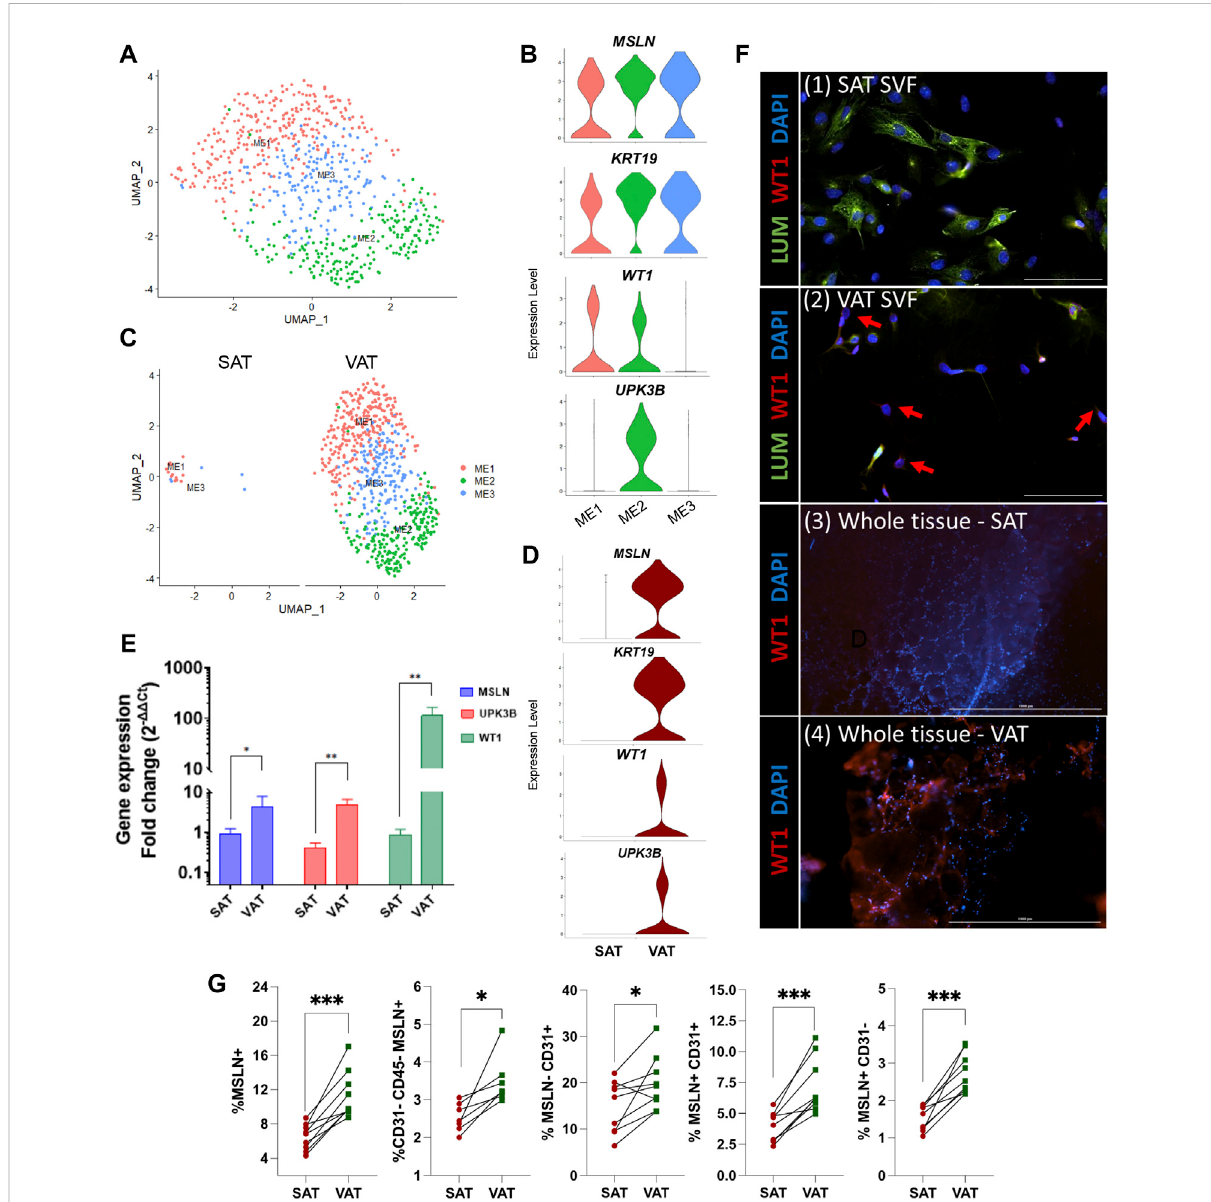
FIGURE 4 MesothelialcellsareaVAT-speci fi ccelltype. (A) UMAPplotofMEacrossvisceral(VAT)andsubcutaneous(SAT)adiposetissueofdairycows(n= 3) obtained through snRNA-seq analysis. (B) Violin plots of ME marker genes MSLN, KRT19, WT1 and UPK3B in ME subtypes. The y axis indicates log- transformedexpressionvalues,andthewidthindicatesthenumberofcellsexpressingthegene. (C) UMAPplotsofVATandSATME. (D) Violinplotsof MEmarkergenesinSATandVAT.The y axisindicateslog-transformedexpressionvalues,andthewidthindicatesthenumberofcellsexpressing the gene. (E) Comparison of adipocyte relative to preadipocyte gene expression fold change of ME marker genes ( MSLN, UPK3B, and WT1 ) between SAT and VAT (n = 4). For gene expression fold change calculations, adipocyte MSLN, UPK3B, and WT1 expression were calibrated by preadipocyte expression in matched SAT and VAT samples from each cow. (F) Immuno fl uorescence imaging of (1) SAT and (2) VAT SVF stained with LUM (green), WT1 (red), and DAPI (blue) (×20 objective, 100 µm scale bars), and (3) SAT and (4) VAT whole tissue (×4 objective, 1,000 µm scale bars) stained with WT1 (red), and DAPI (blue). Red arrows highlight WT1+ cells. (G) Flow cytometry analysis of SAT and VAT SVF from an independent cohort of dairy cows (n = 10) showing percentages of (from left to right): Total ME cells (MSLN+); ME cells (MSLN+) in ASPC (CD31 − CD45 − ) population; CD31 + cells that do not express MSLN; CD31 + cells that express MSLN; and ME cells (MSLN+) that do not express CD31. * p value ≤ 0.05 and; *** p value ≤ 0.0001 using paired t